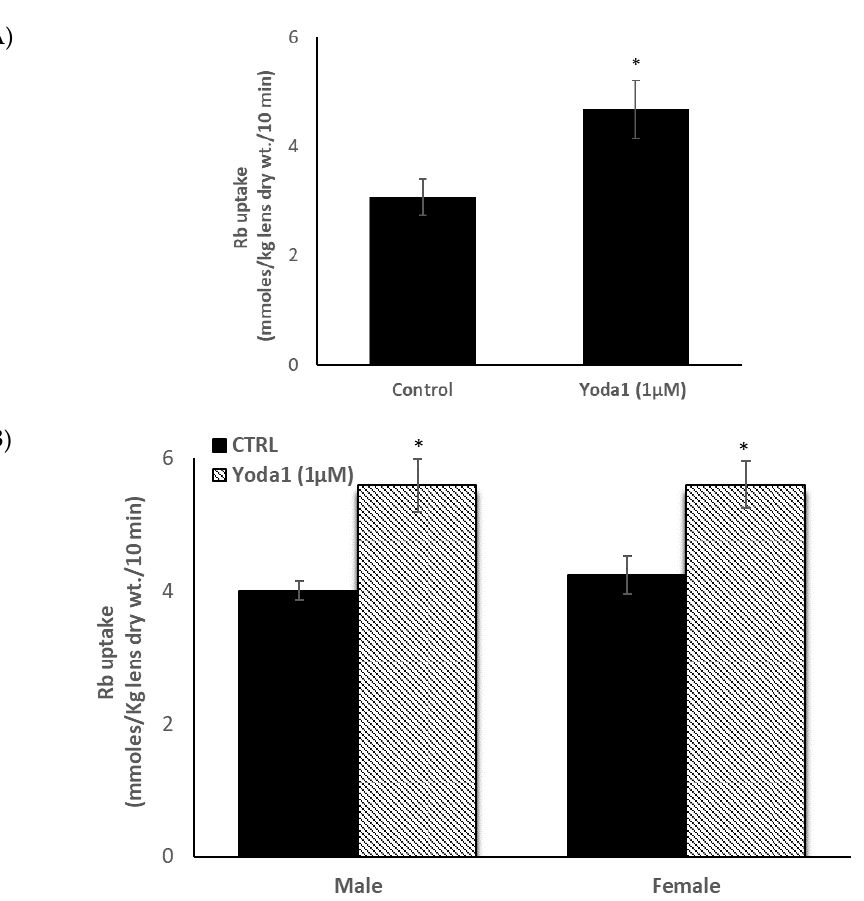
Figure 3. The influence of Yoda1 on rubidium (Rb) uptake by intact male mouse lenses. Lenses were incubated for 10 min in Rb-containing Krebs solution + 1 µM Yoda1 ( Panel A ). In a separate experiment, Rb uptake was compared between lenses from male and female mice ( Panel B ). The values are the mean ± SEM of results from 5 – 7 lenses. * Indicates a significant difference ( p < 0.05) from the control, as determined by two sample t -tests.